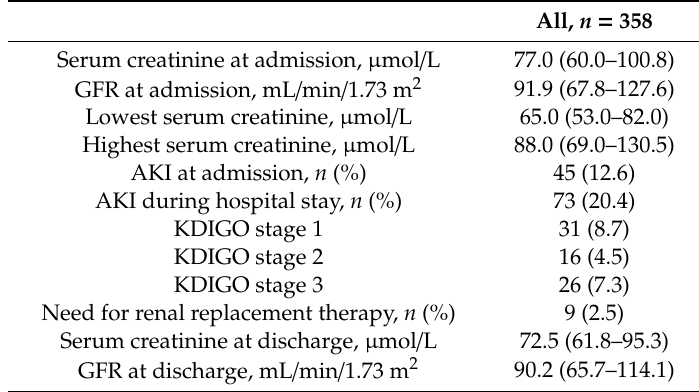
Table 3. Kidney function and acute kidney injury (AKI) characteristics in the study population. Results are presented as median (IQR) and absolute value (percentage). All, n = 358 Serum creatinine at admission, µ mol /